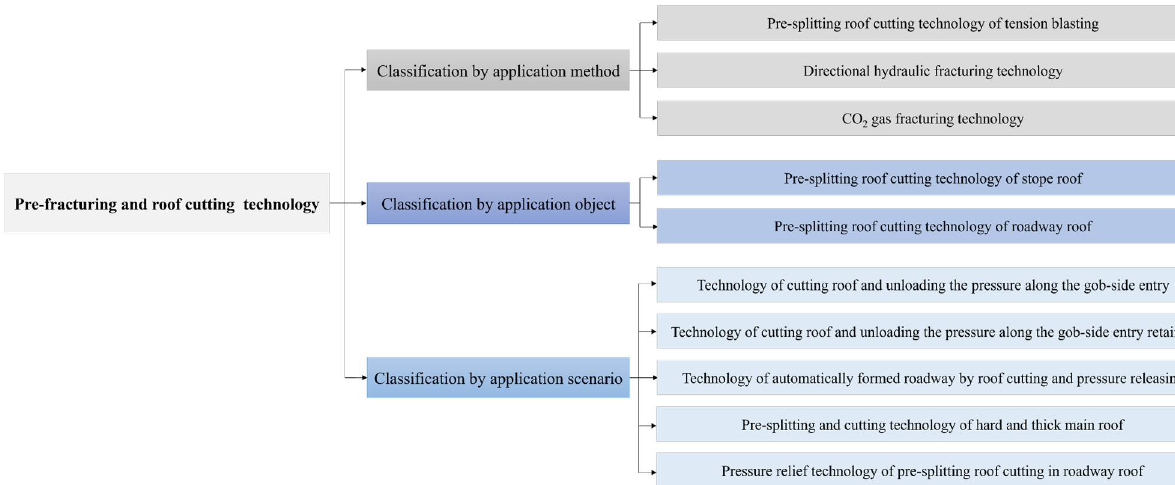
Figure 1. Category of pre-splitting and roof-cutting technology.